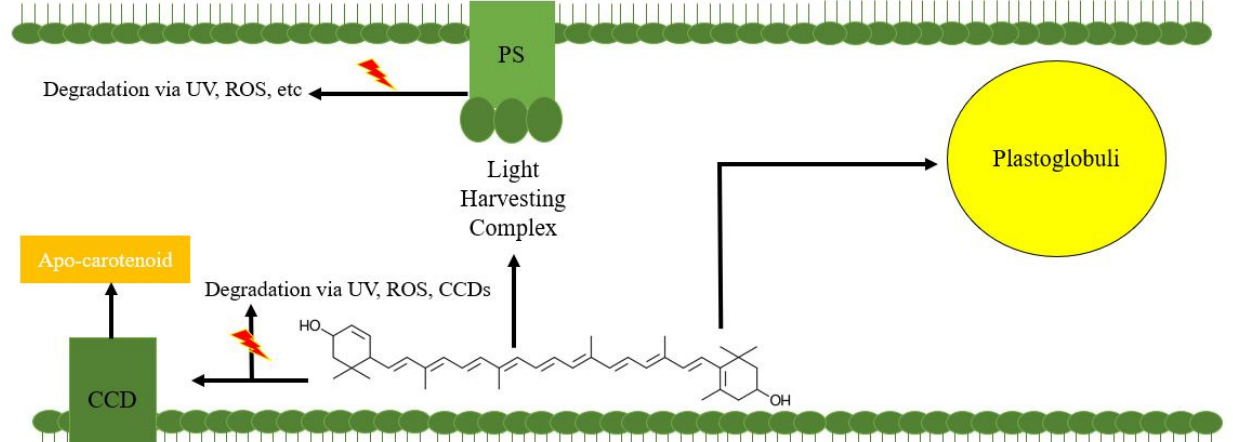
Figure 1. The sequestration of lutein in photosynthetic organisms. PS: photosystems. UV: ultraviolet light. ROS: reactive oxygen species. CCD: carotenoid cleavage dioxygenases.